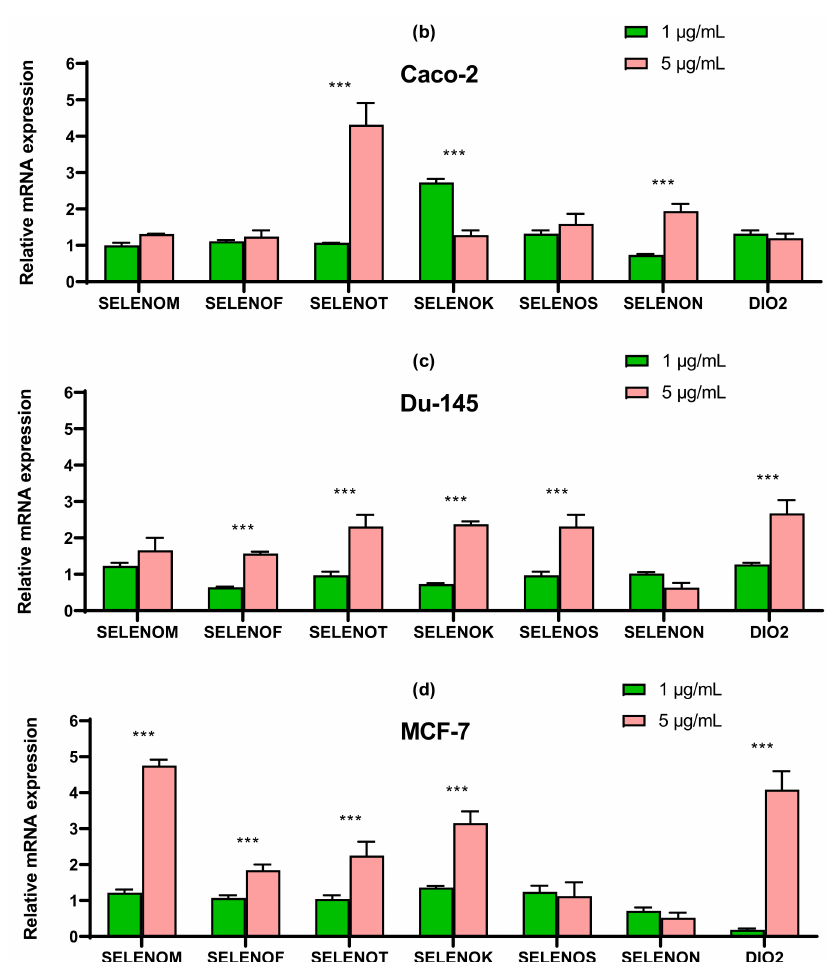
Figure 8. qRT-PCR analysis of the expression of ER resident selenoprotein gene (1 and 5 µ g/mL SeNP, 24 h)-treated cancer cells ( a )—A-172; ( b )—Caco-2; ( c )—Du-145; ( d )—MCF-7. Each value is the mean ± SD of at least three independent experiments ( n ≥ 3, p < 0.05). GAPDH was used as an internal control for normalization. Two-way ANOVA with Sidak’s multiple comparisons test. Comparison 1 µ g/mL and 5 µ g/mL, *** p -level < 0.001, * p -level < 0.05. In line Caco-2, a more than four-fold increase in expression of SELENOT mRNA can be distinguished compared with control (Figure 8b). In prostate carcinoma cells, SeNP did not